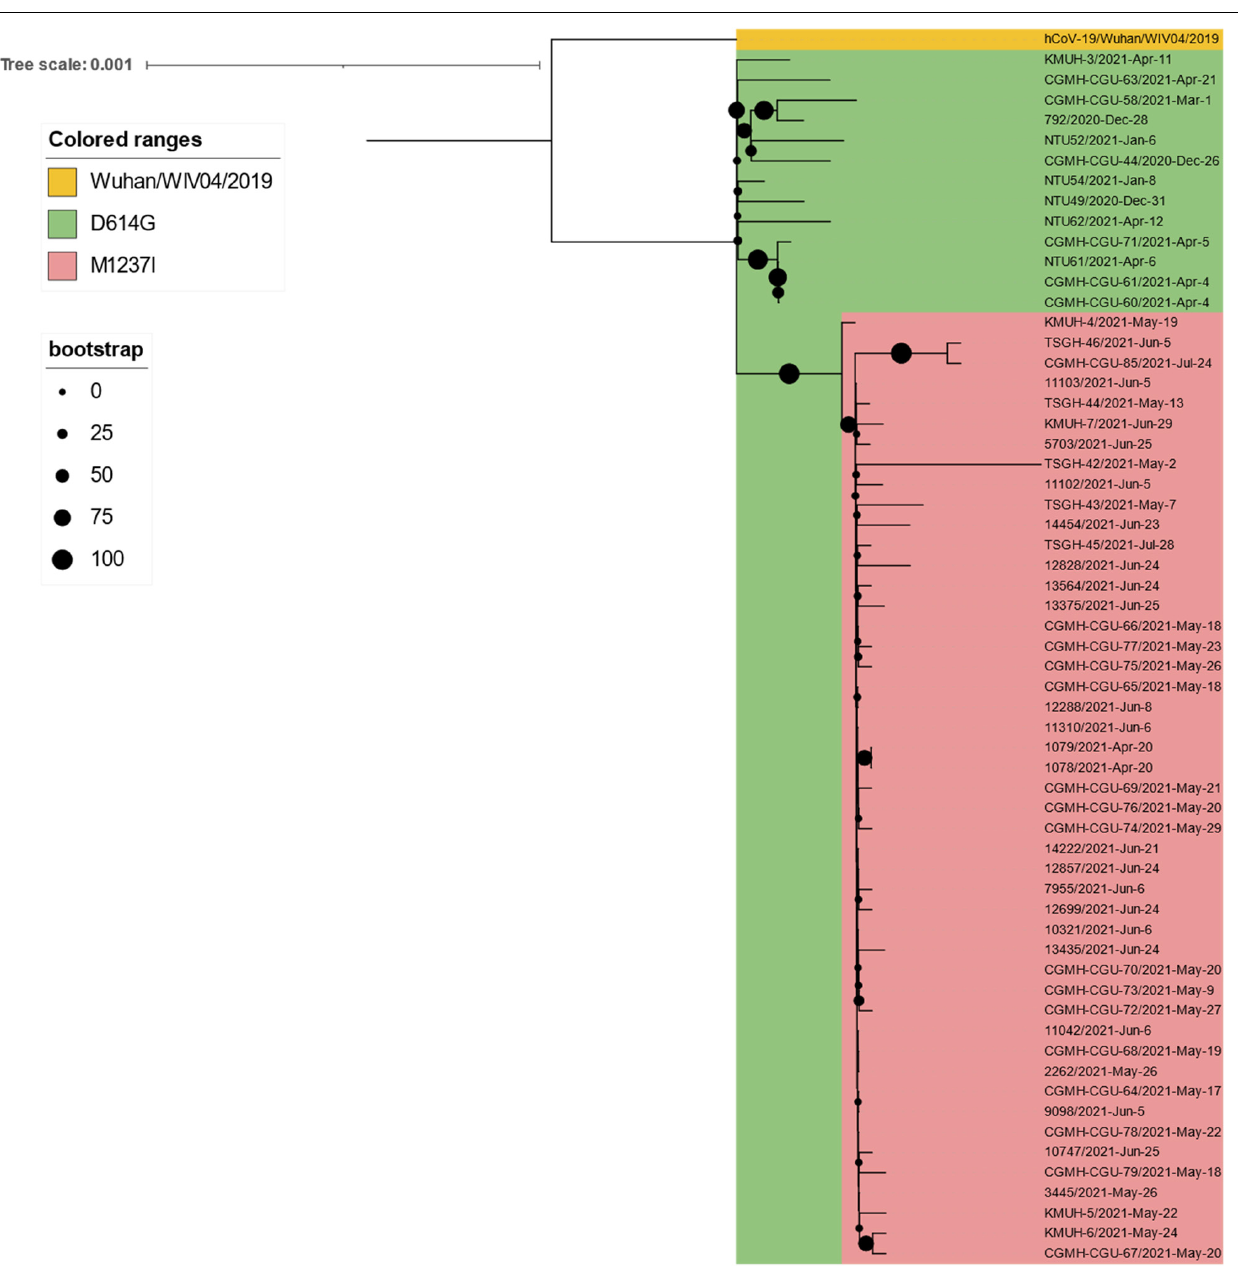
FIGURE 6 | Phylogenetic tree of all 60 alpha/B.1.1.7 sequences deposited in GISAID EpiCoV from samples collected in Taiwan between January 2020 and December 2021. The phylogenetic analysis was inferred by using the maximum likelihood and fits of 286 different nucleotide substitution models, and the results suggested TN + F as the best-fitting model with the lowest Bayesian information criterion (BIC) scores of 85,071.899 among the 286 models tested. The tree topology was automatically computed to estimate the maximum likelihood values. The optimal log-likelihood for this computation was –42,000.232. There was a total of 29,796 positions in the final dataset. The original tree is displayed using iTOL v 6.4.3 (https://itol.embl.de/) (73) with an indicator of bootstrap values and a scale bar. Viruses are shown as the virus name| collection